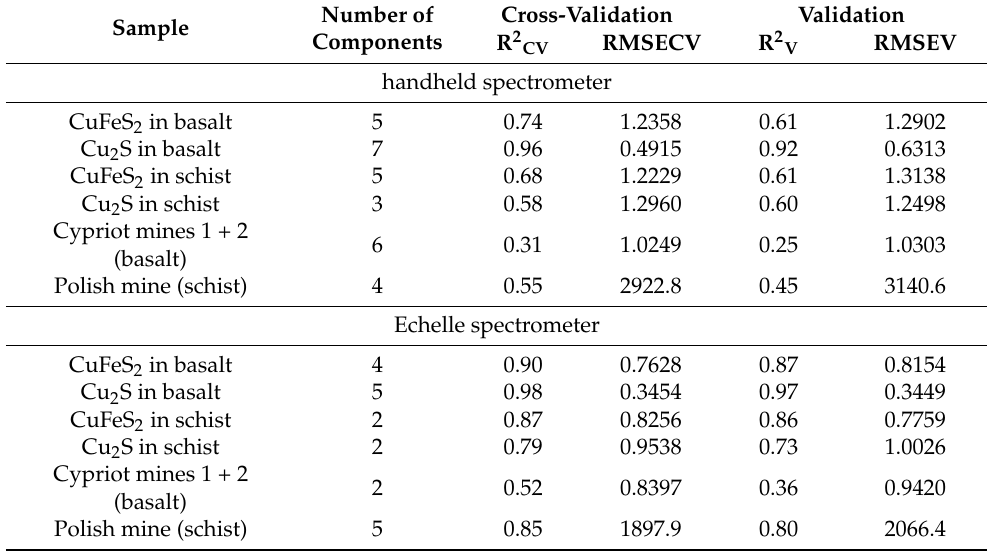
Table 3. PLSR results of the examined samples in basalt and schist at Handheld and Echelle spectrom- eter after elimination of outliers by the robust principal components analysis (ROBPCA)